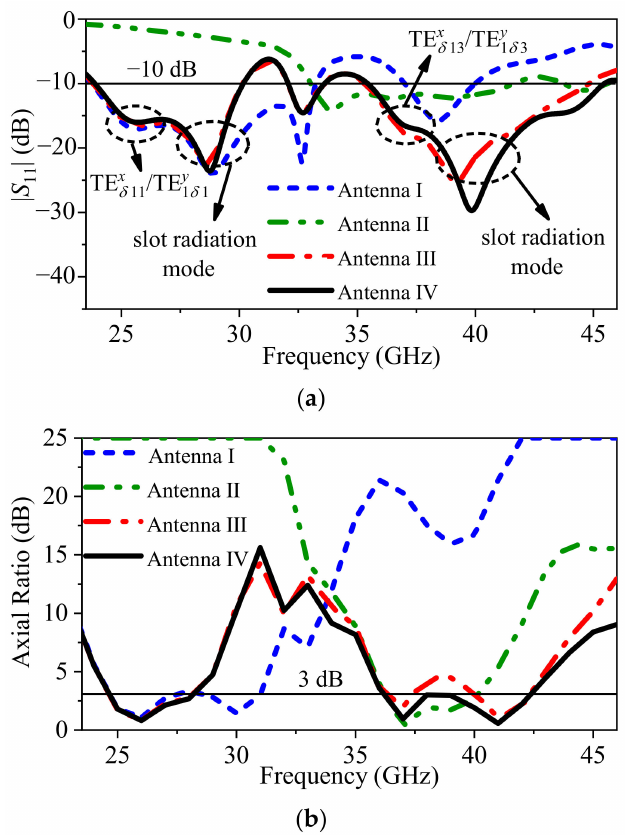
Figure 3. Simulated results of the four types of antennas: ( a ) Reflection coefficients; ( b ) ARs toward ( θ = 0 ◦ ; ϕ = 0 ◦